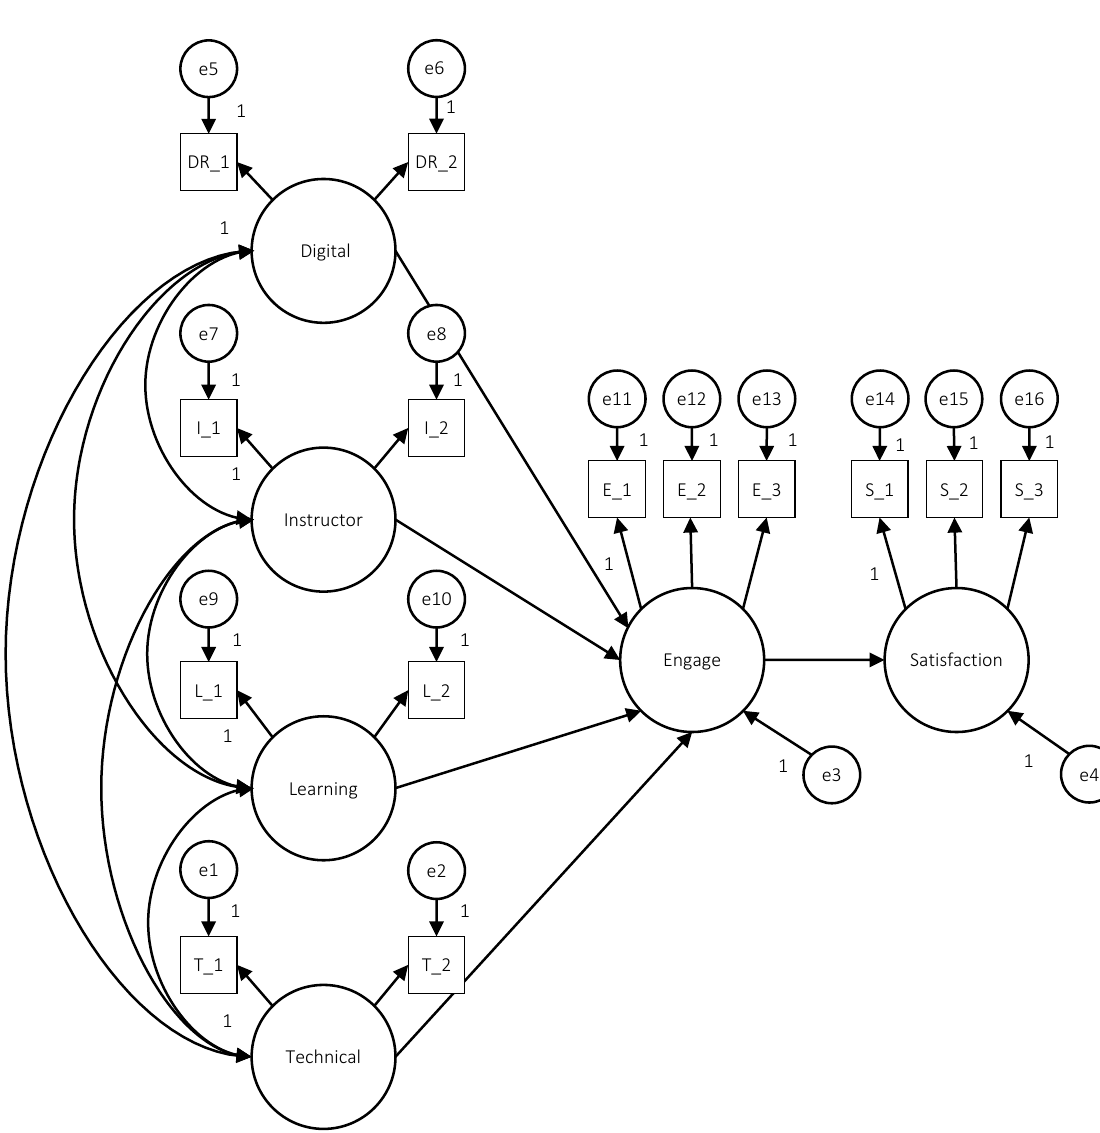
Figure 2. Model in AMOS